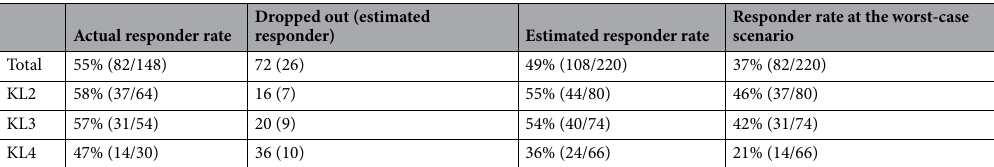
Table 3. Responder rate in the OMERACT–OARSI criteria. KL Kellgren–Lawrence.